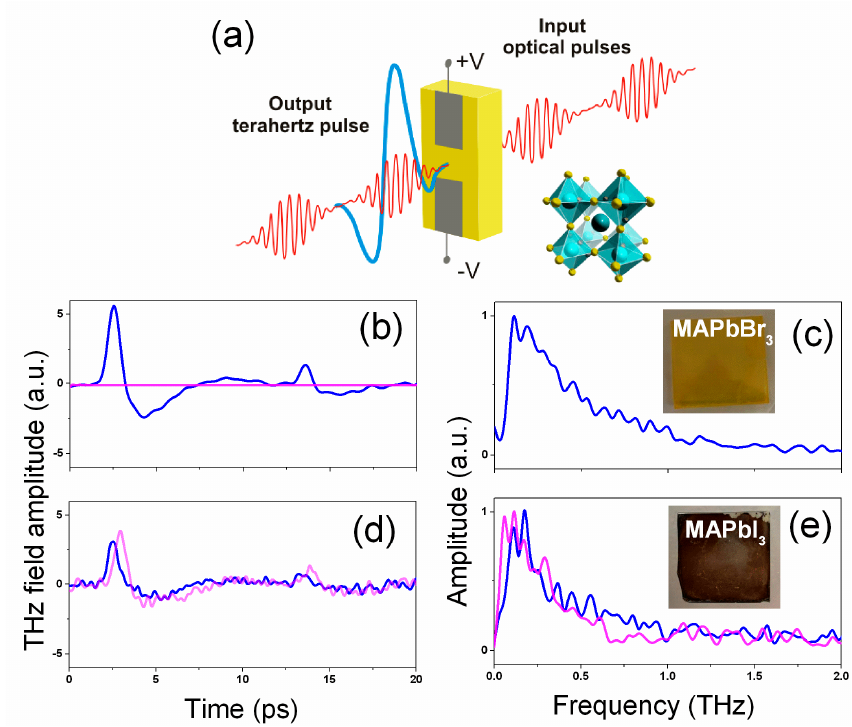
Figure 5. ( a ) Scheme of the THz emission from an HP-LAPCA (large-aperture photoconductive antenna). Time domain waveforms of the THz emission from MAPbI 3 ( b ) and MAPbBr 3 ( d ) and corresponding frequency domain spectra ( c , e ) obtained under above and below the bandgap excitation. The data obtained under 400 and 800 nm excitations are shown in blue and magenta colors.